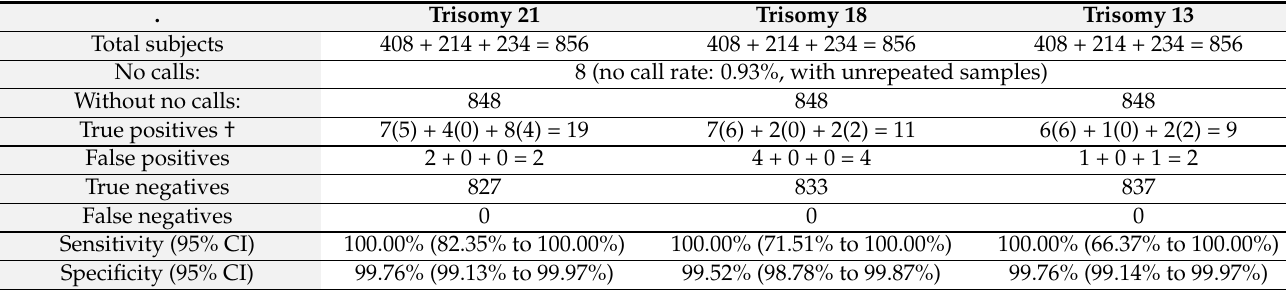
Table 2. Test performance Vanadis ® NIPT–Aneuploidy (Sweden + Malaysia + USA). .